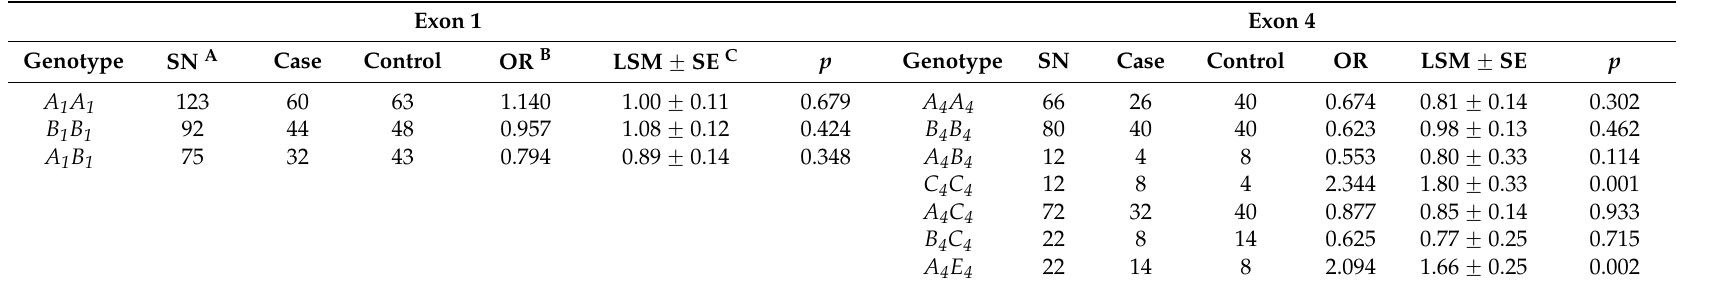
Table 3. Association between genotypes of SLA-DRA exons and piglet diarrhea in Yantai black